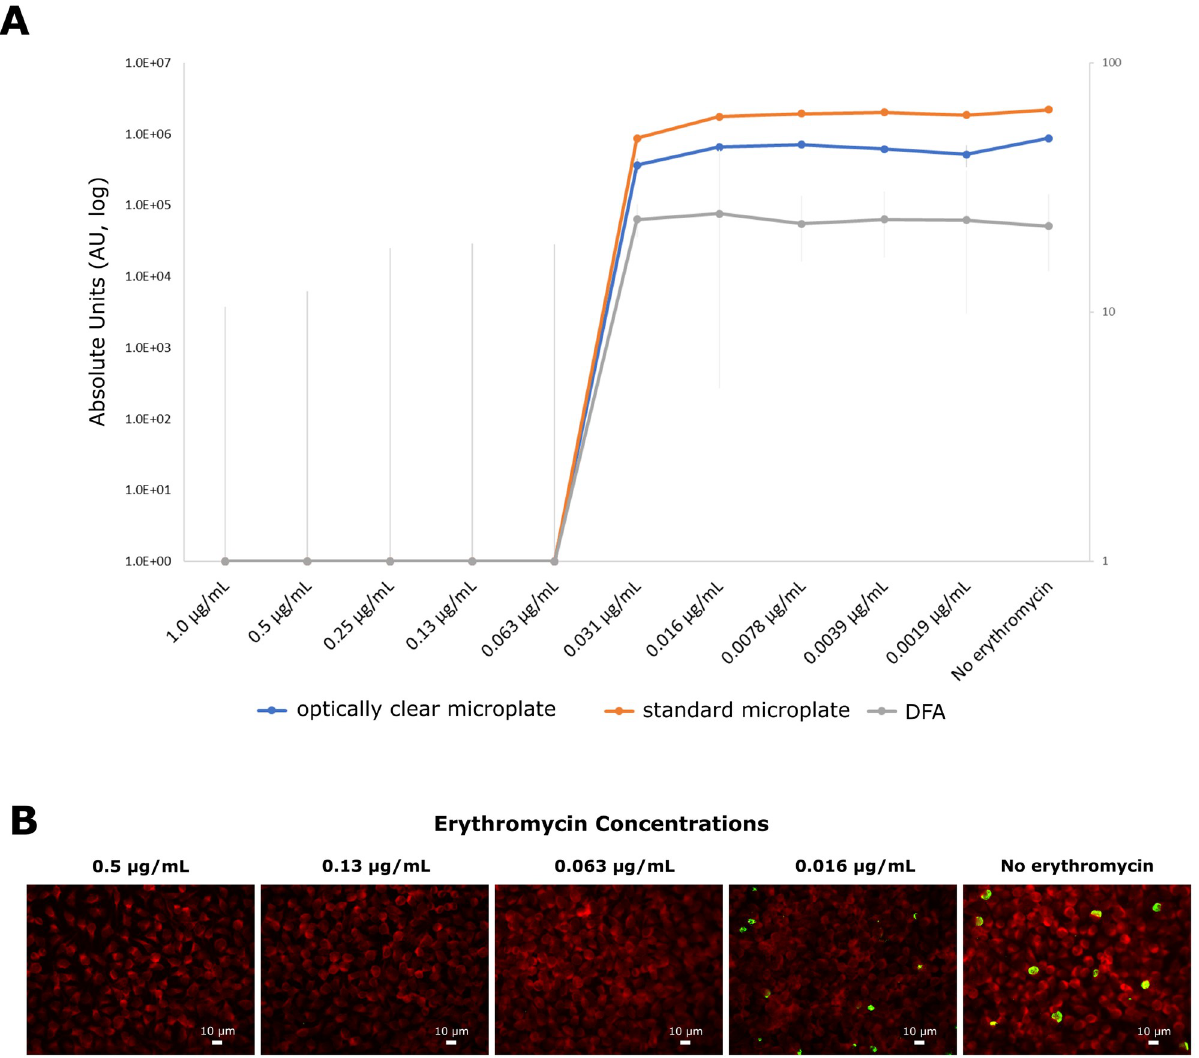
Fig 3. Susceptibility of C . trachomatis to erythromycin by ICW and DFA assays. Confluent McCoy cell monolayers, grown in either 96-well cell culture microplates or on coverslips in 24 well cell culture microplates, were infected with C . trachomatis EBs at a MOI of 1.0. Subsequently, cell monolayers were challenged with two-fold serial dilutions of erythromycin (from 1.0 μ g/mL to 0.0019 μ g/mL) and, then, incubated for 36 hours at 37˚C and 5% CO 2 . 96-well microplates were then fixed in 4% PFA, permeabilized by 0.1% triton x-100 in PBS and analysed via Odyssey CLx, whereas 24-well microplates were fixed with 96% ice cold methanol and analysed via fluorescence microscopy. (A) Near-infrared absorbance data via ICW and chlamydial IFU via DFA in relation to erythromycin concentrations; (B) Immunohistological staining of infected cell monolayers treated with the erythromycin concentrations corresponding at MIC (0.063 μ g/mL) and MIC TP (0.0019 μ g/mL) and untreated cells.